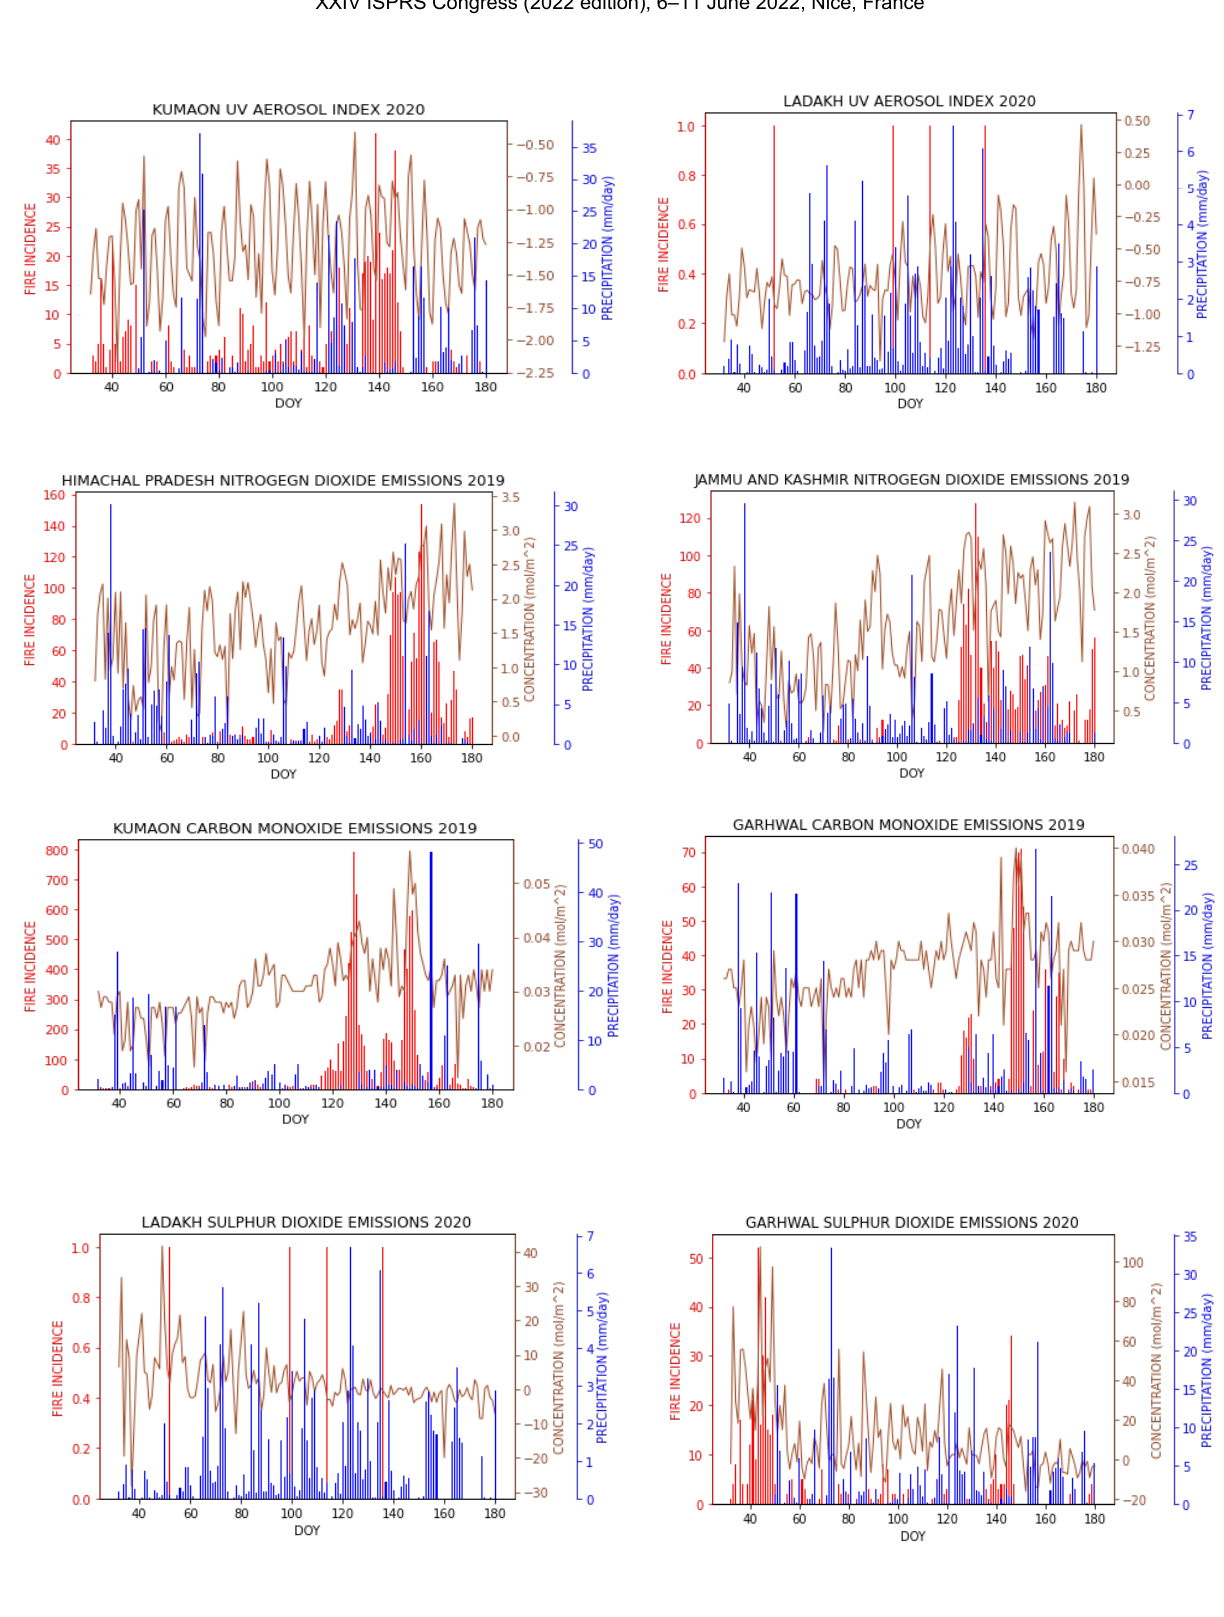
Figure 5: Graphs showing UV AI, concentration of Formaldehyde, Carbon Monoxide, Nitrogen Dioxide and Sulphur Dioxide with precipitation during the fire season of some selected places and year of the study